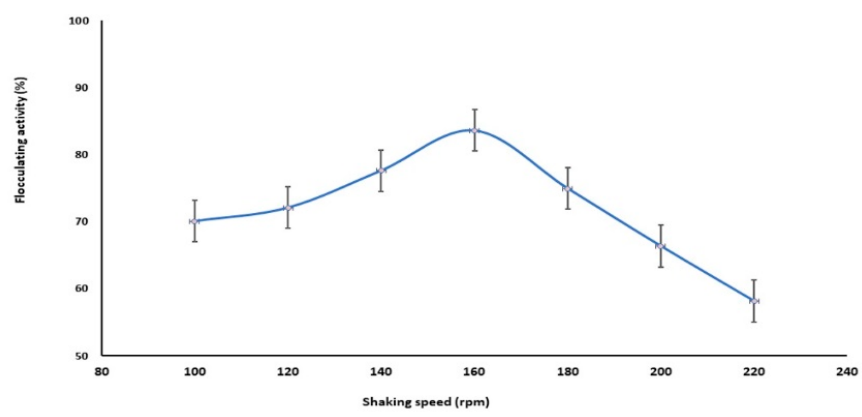
Figure 4. Effect of shaking speed on bioflocculant production.